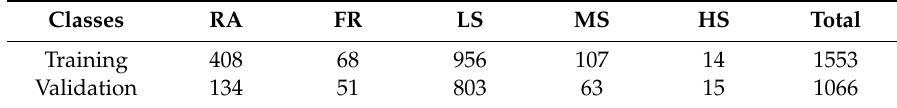
Table 3. The sample size of precipitation classes for the training (2012–2013) and validation (2014–2015) periods.